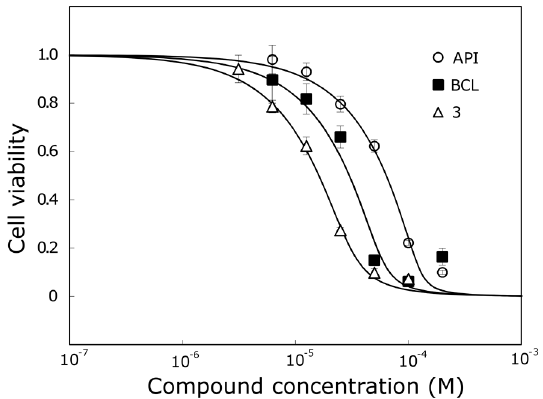
Figure 5. The activity of API, BCL and compound 3 against MCF-7 cell line.